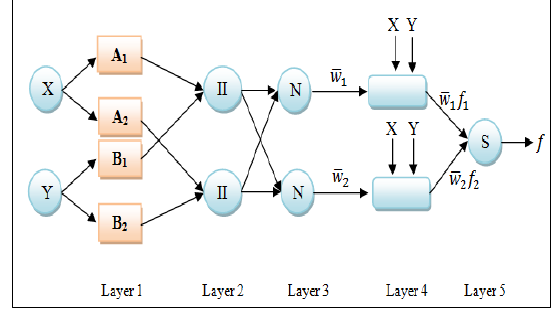
Figure 1. Structure of a simple ANFIS system.